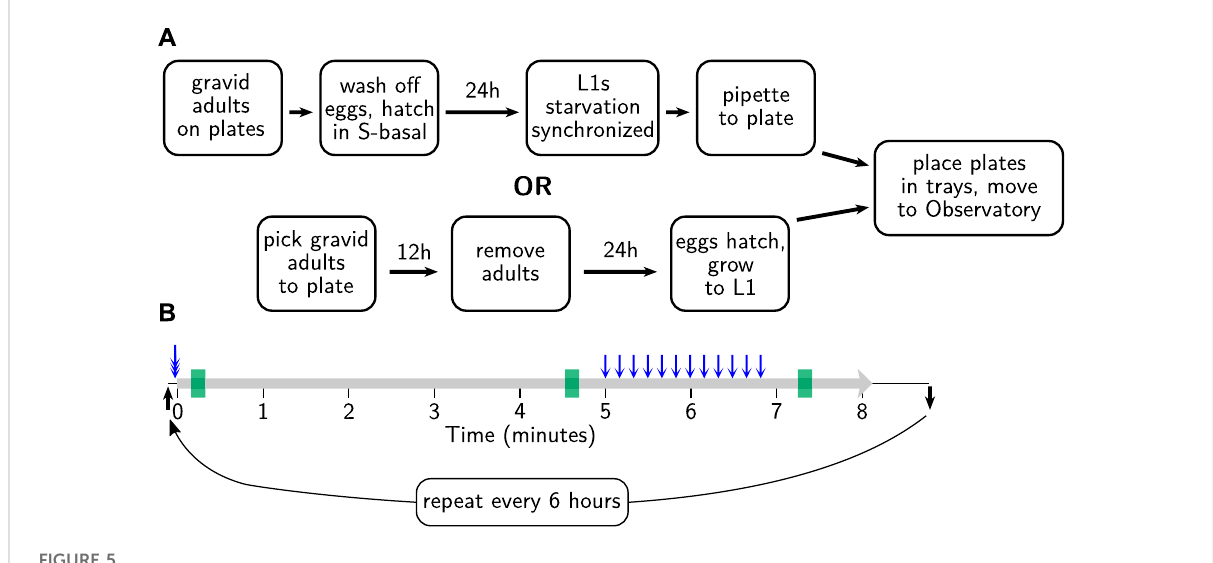
FIGURE 5 Sample preparation and behavioral assay protocols. (A) Age synchronization. One of two standard methods is used to synchronize progeny at 15 ° C,asshown,beforemovingtotheObservatoryat25 ° C. (B) Behavioralassay.Trayarrivesattheimagingplatform(blackarrow);trayistriple-tapped (blue triple-headed arrow) prior to the onset of recording (thick gray line). After 300 s, 12 taps are delivered (blue arrows) with a 10 s inter-stimulus interval; after 80 more seconds, recording ceases. Tray is removed shortly thereafter (black arrow) until the next session, 6 h later. Summary parameters are gathered in 10 s windows at 10, 275, and 440 s (green rectangles), corresponding to initially active, calmed, and tap-aroused behavioral